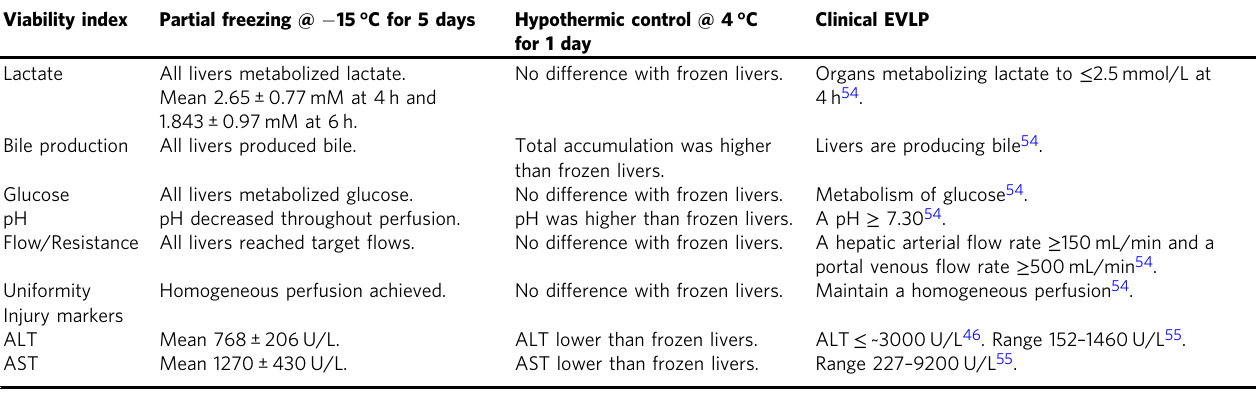
Table 1 Rodent livers that were partially frozen at − 15 °C for 5 days are viable using our 6-our perfusion model as compared to transplantable controls and/or clinical liver perfusion data, representing a fi vefold extension of preservation